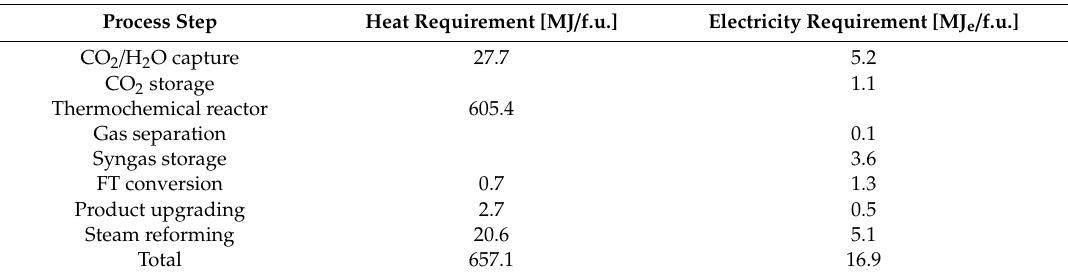
Table A4. Energy requirements for process steps.